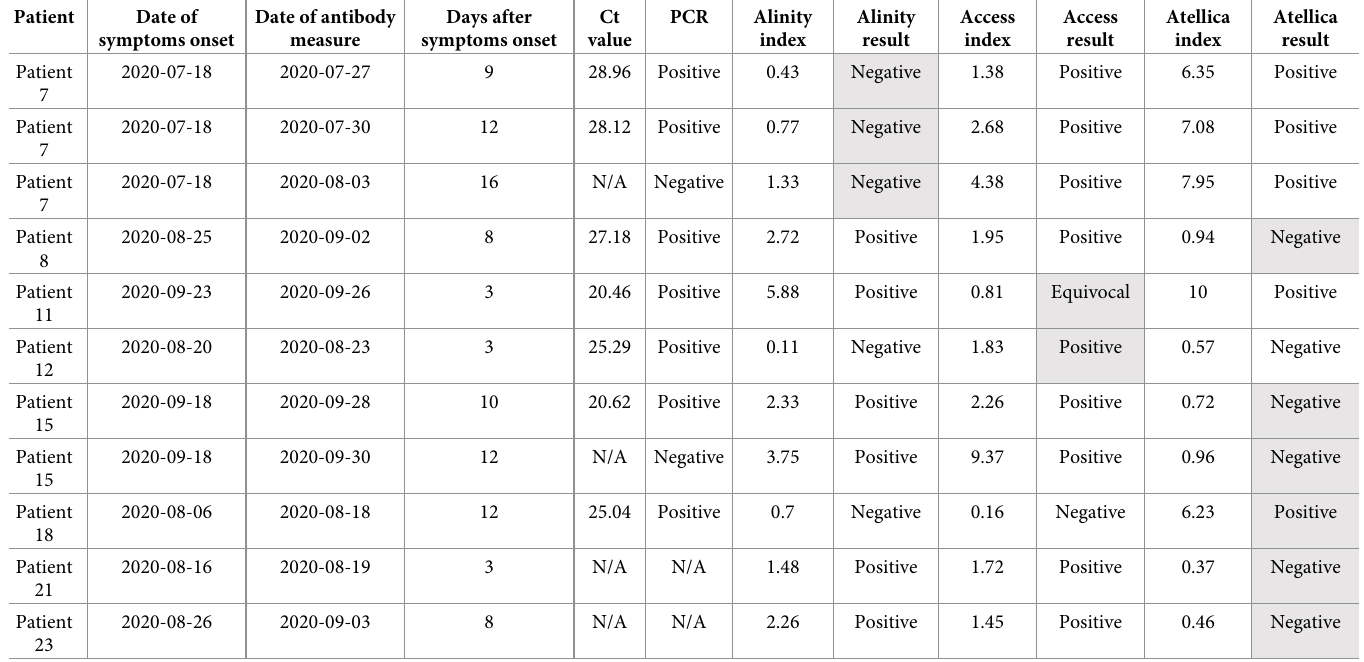
Table 3. Patients showed discrepancy in SARS-CoV-2 antibody positivity in three automated immunoassay system. Patient Date of Date of antibody symptoms onset